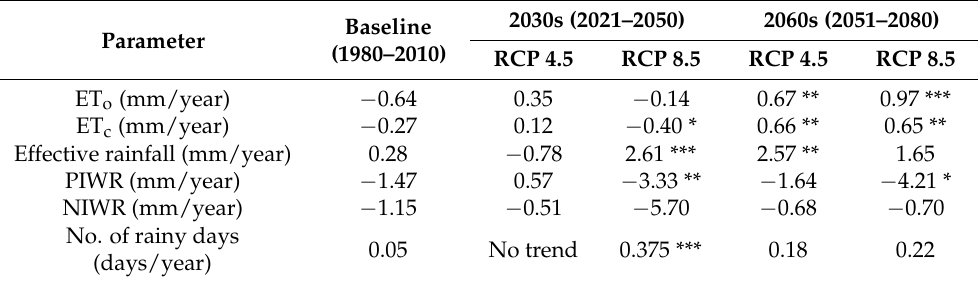
Table 3. Sen’s slope of trends for the rice irrigation management components during the baseline and future time